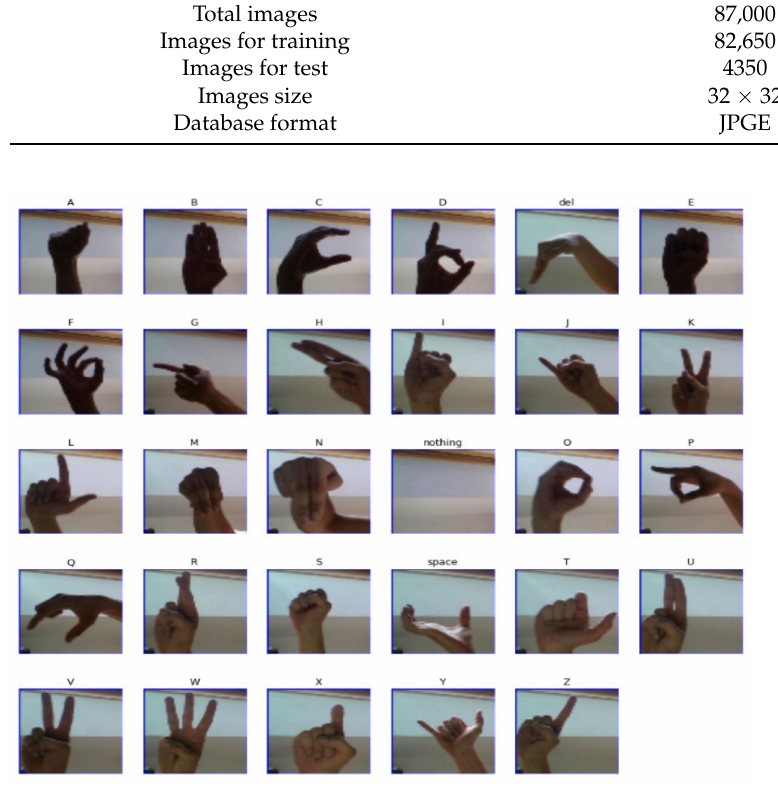
Figure 11. A sample of the ASL alphabet